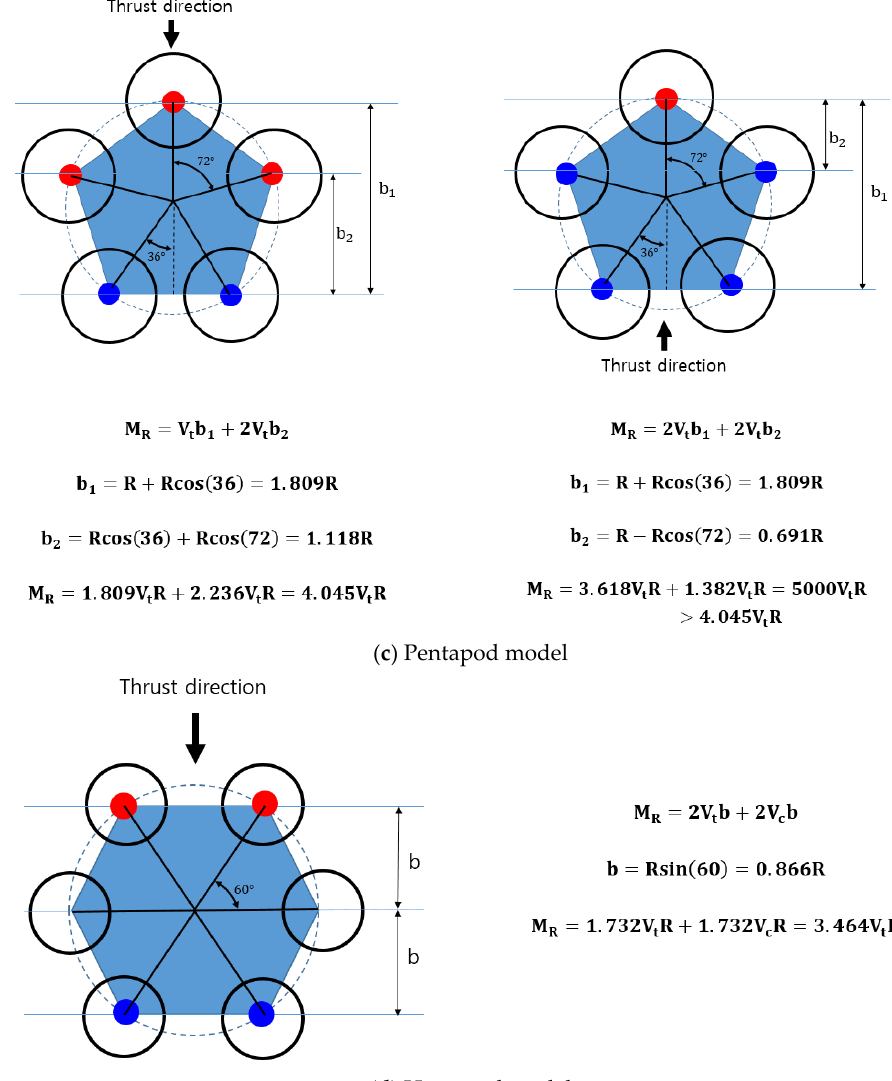
Figure 8. Top view of multi-pod buckets.